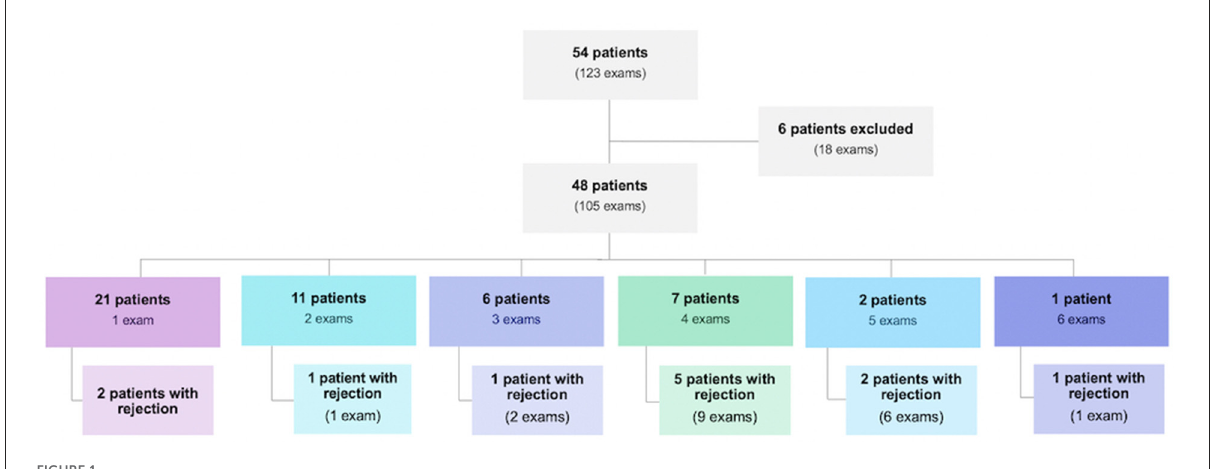
FIGURE1 Population of heart transplant patients evaluated during the study period and their distribution regarding the number of endomyocardial biopsies performed and the presence of rejection.